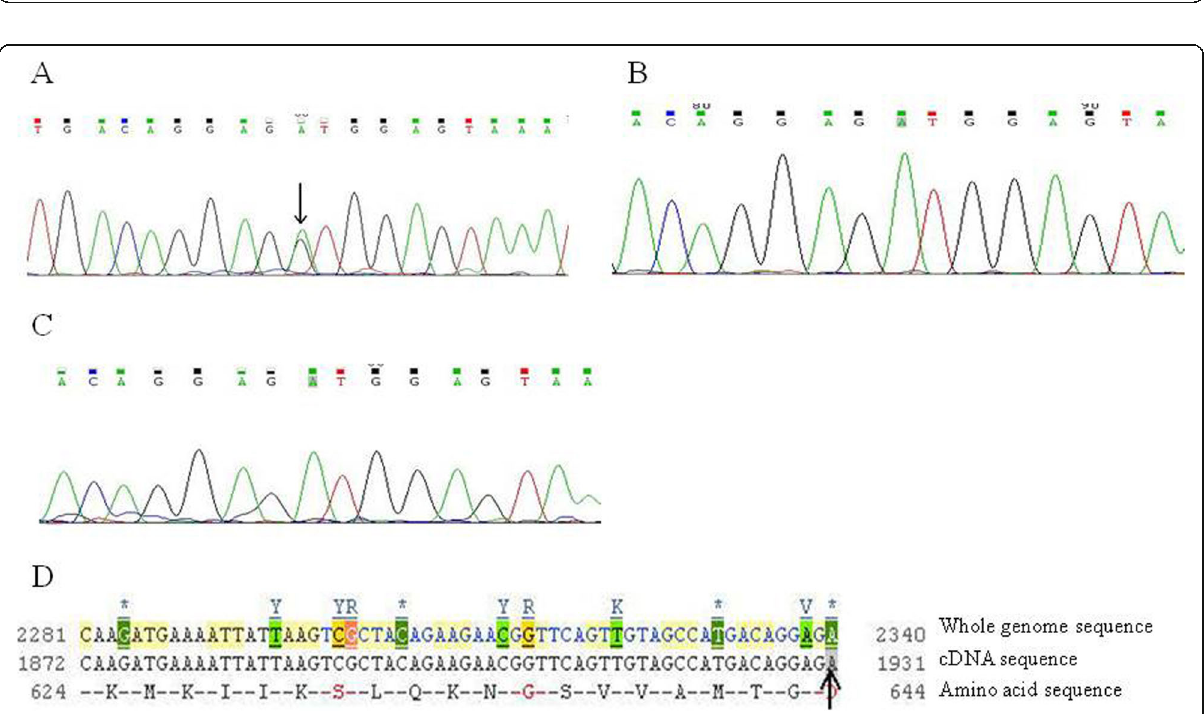
Fig. 5 Exon 8 sequencing for the ATP2C1 gene in sporadic case I. a Sequencing result of exon 8 in sporadic case I. b Sequencing result of exon 8 for normal member in the same pedigree. c Sequencing result of exon 8 for normal individual who was not blood related. d A nonsense mutation c.C635A(Bases C → A) in exon 8 of ATP2C1 gene in the Ensemble database (indicated by